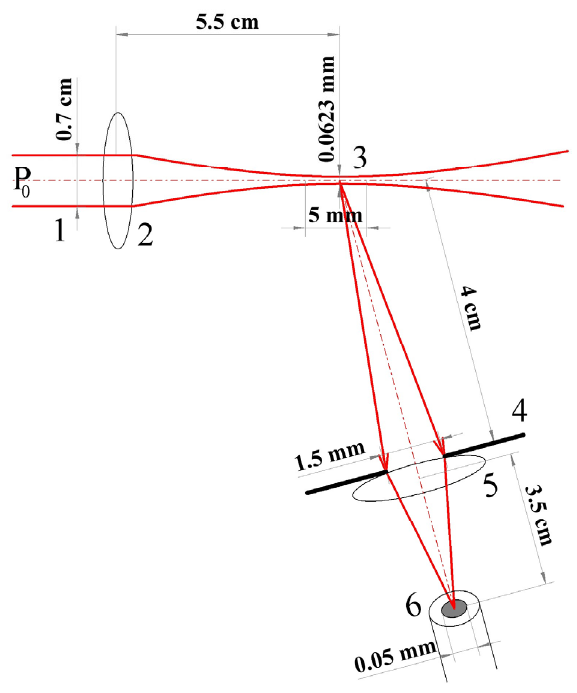
Figure 7. Optical system of registration parts of the measuring system. 1—transmitted beam, 2,5—focusing spherical lens, 3—scattering volume, 4—iris diaphragm, 6—input aperture of the optical fi ber.